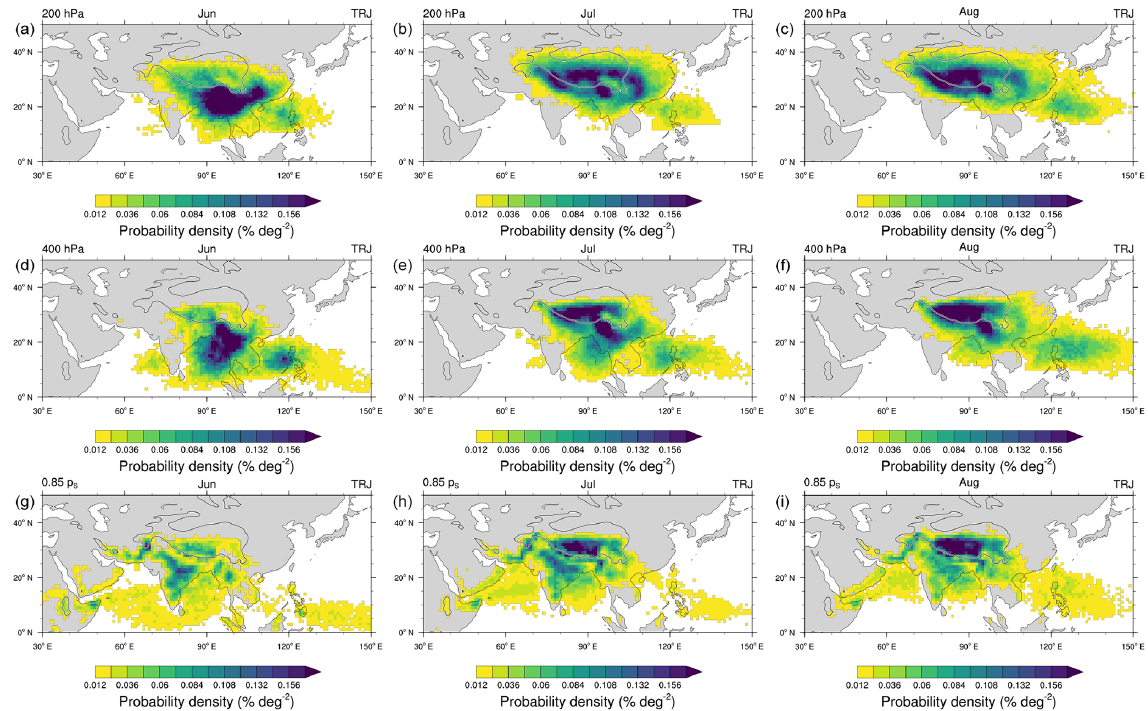
Figure 10. Probability density (%deg − 2 ) of trajectory (upward) crossings at (a, b, c) 200hPa, (d, e, f) 400hPa and (g, h, i) the PBL as in Fig. 3 but split according to (a, d, g) June, (b, e, h) July and (c, f, i) August.